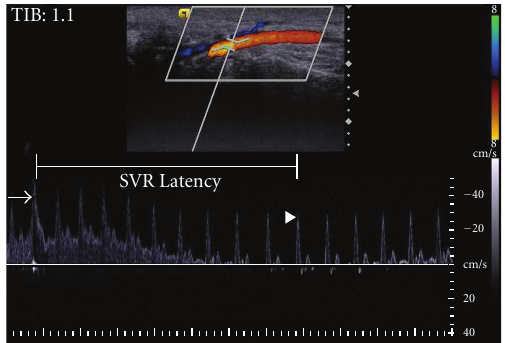
Figure 1: Change of Doppler wave forms upon sympathetic vasomotor response (SVR). The inspiratory cough causes an arti- fact (arrow) and decreases systolic blood velocity with a more prominent diastolic reversal. The wave of maximal deflection (arrowhead) was used to represent the hemodynamic status after sympathetic stimulation. The SVR latency indicated the period between the artifact by inspiratory cough to the maximal deflection of Doppler wave